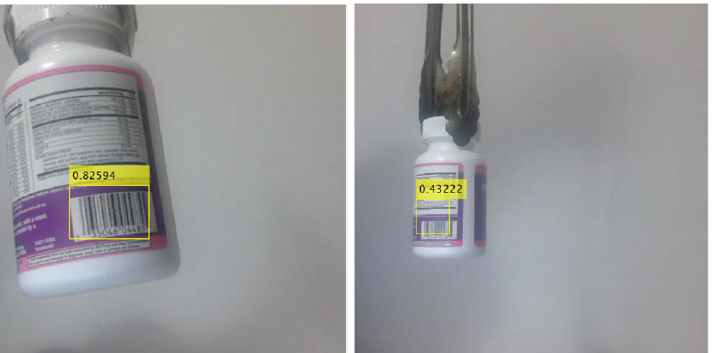
Figure 26. Detection of clear barcodes with high confidence score and unclear one with a lower confidence